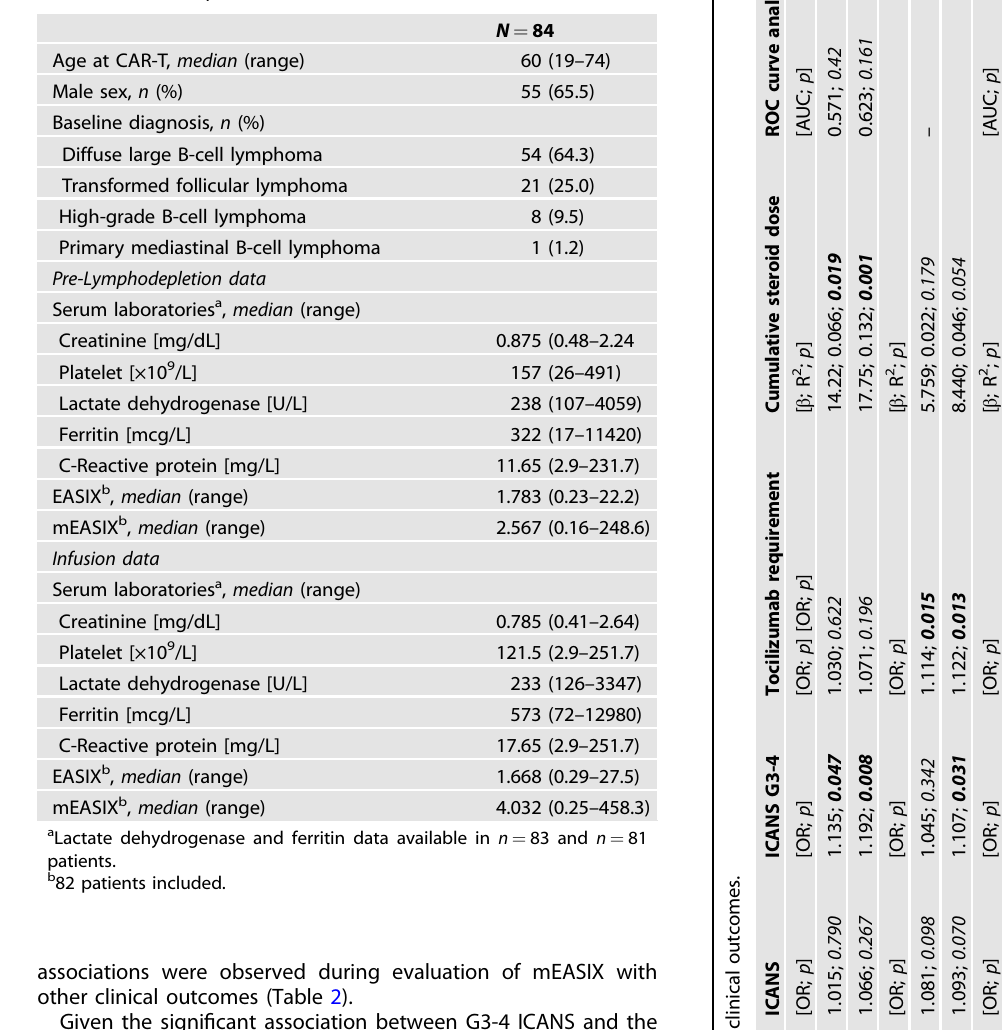
Table 1. Baseline patient